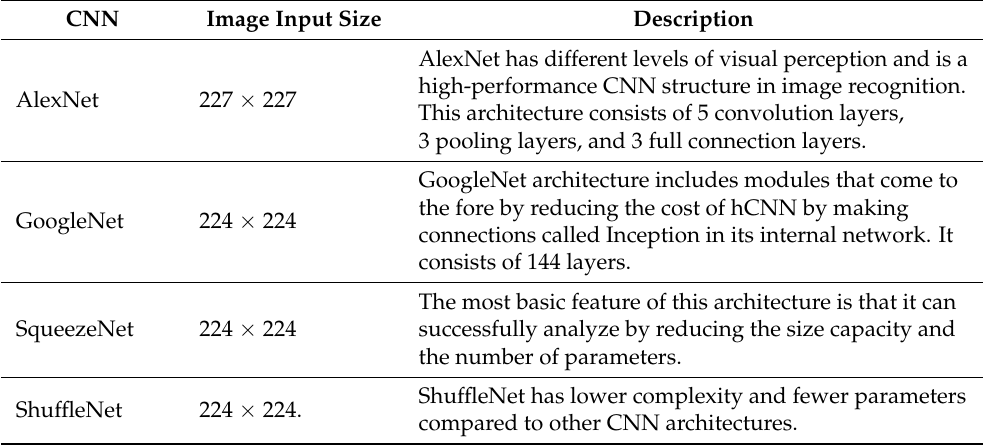
Table 3. General characteristics of pre-trained CNN networks